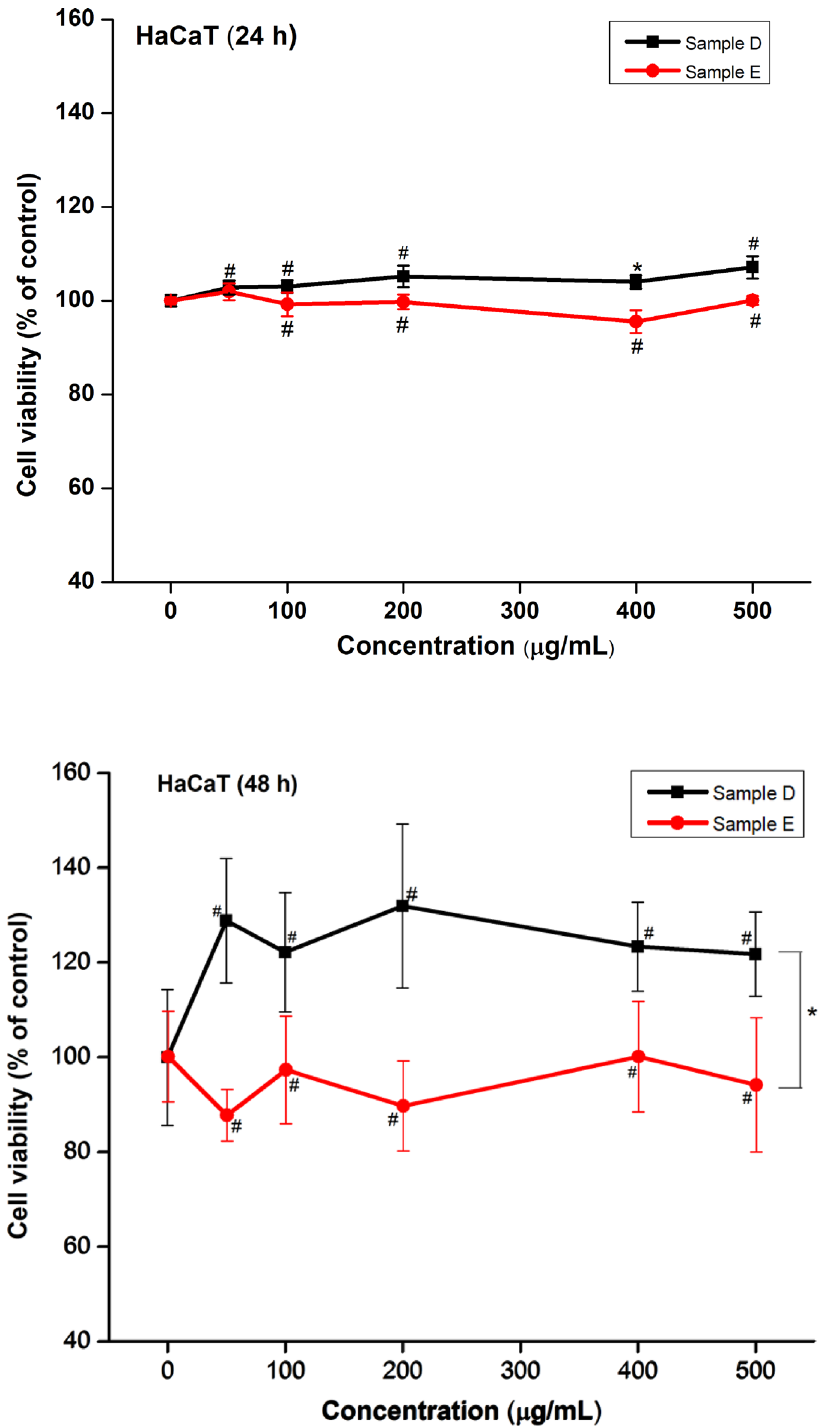
Figure 1. Effect of hand gel on viability of HaCaT after 24 h and 48 h. The results are expressed as mean ± standard error of mean, N = 3, The statistical analysis was performed using ANOVA, p-value more than 0.05 was considered as statistically insignificant. *p < 0.05, # p > 0.05 significant difference vs 0